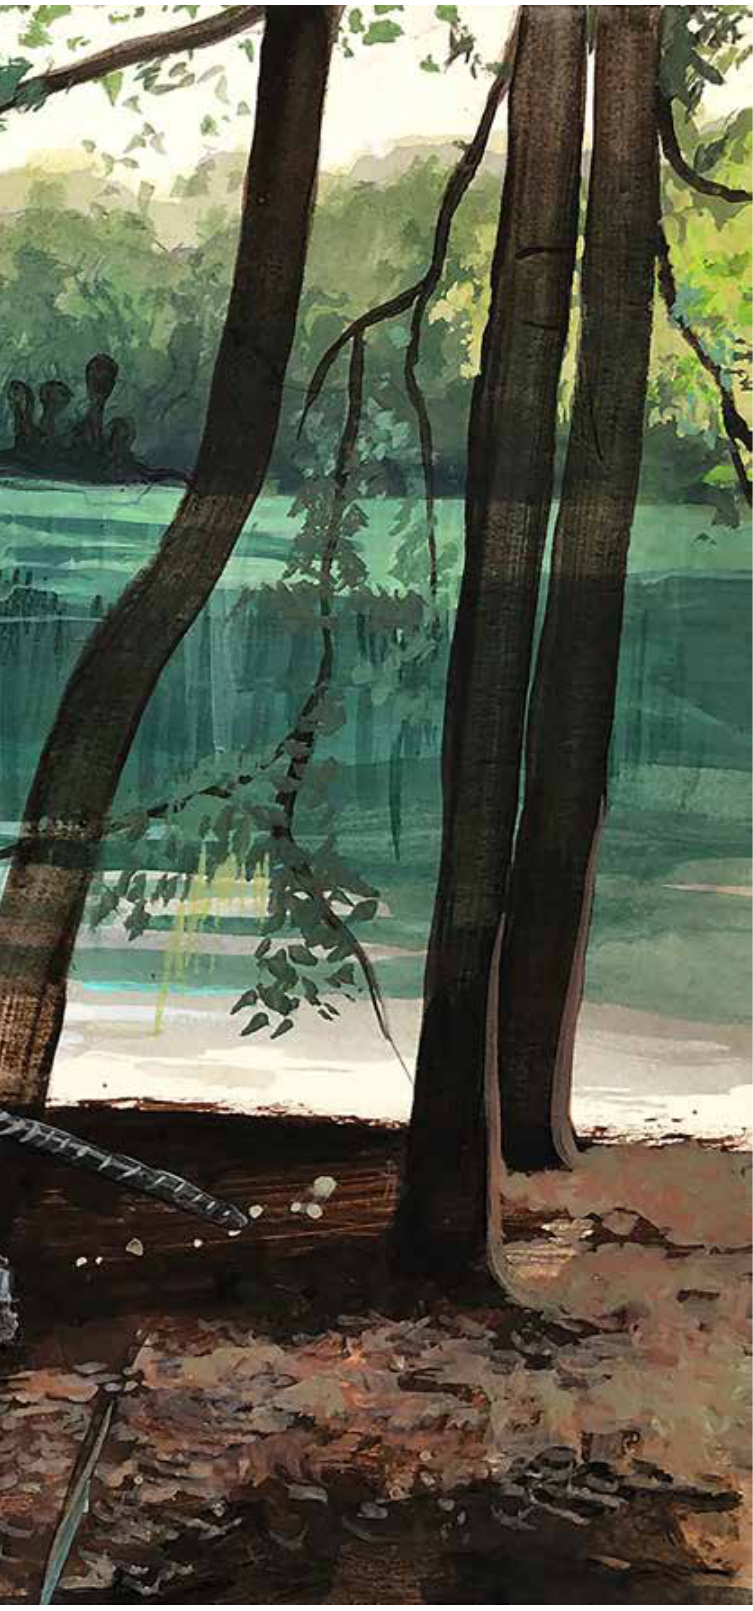
Figure 5: Denise Burge, Shade, 2019. Acrylic on paper, 30.4 x 35.5